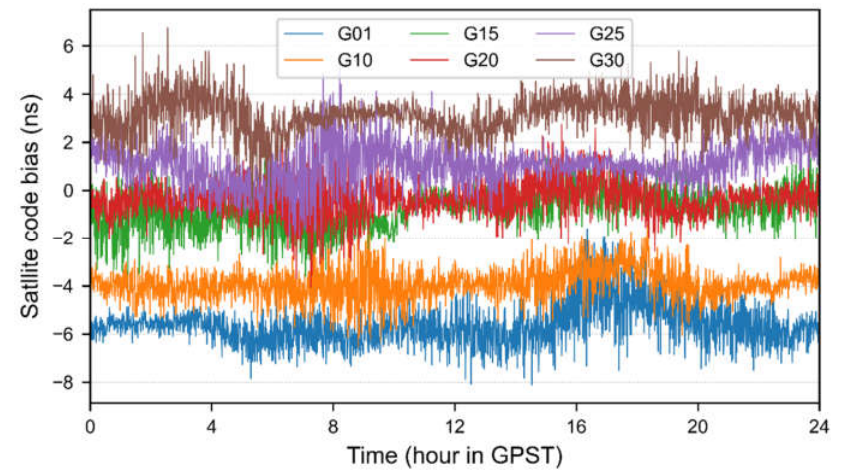
Figure 5. Time series of SCBs extracted by Undifferenced-SRCB model on DOY 031. Additionally, the RCB time series extracted from the Undifferenced-RCB and Undif- ferenced-SRCB models are also displayed in Figures 6 and 7. For the convenience of anal- ysis, only six receivers are displayed, and the time series of each receiver is shifted to dif- ferent degrees. Compared with Figure 6, the white noise characteristic of the RCB in Fig- ure 7 is destroyed, and the constraint of Equation (15) should be responsible for this. Dif- ferent from SCBs, the variation of the RCB with time is more severe. Therefore, if those biases are not driven into code residuals such as Equation (2), it will bring adverse effects on the estimated parameters [25].